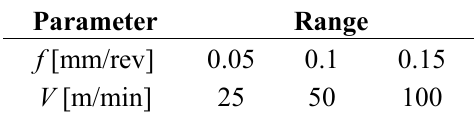
Table 2. Cutting parameters used in drilling tests: f , feed and V , cutting